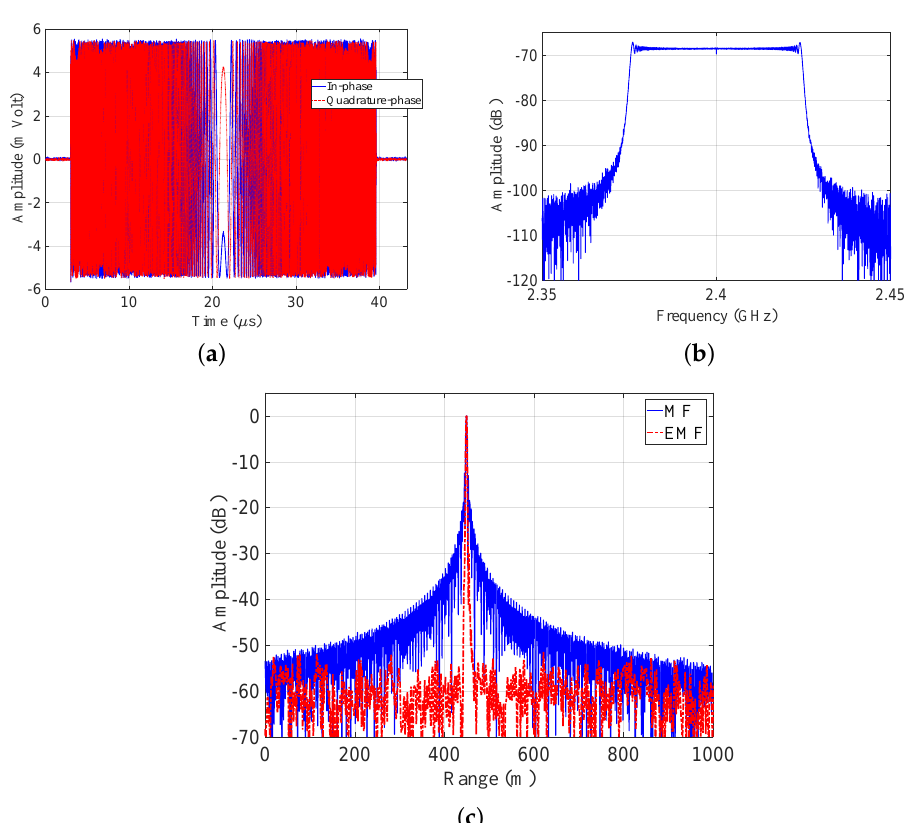
Figure 21. Results of the indoor experimental setup: ( a ) Received signal in the time domain. ( b ) Frequency spectrum of the received LFM signal. ( c ) Amplitude responses of MF and